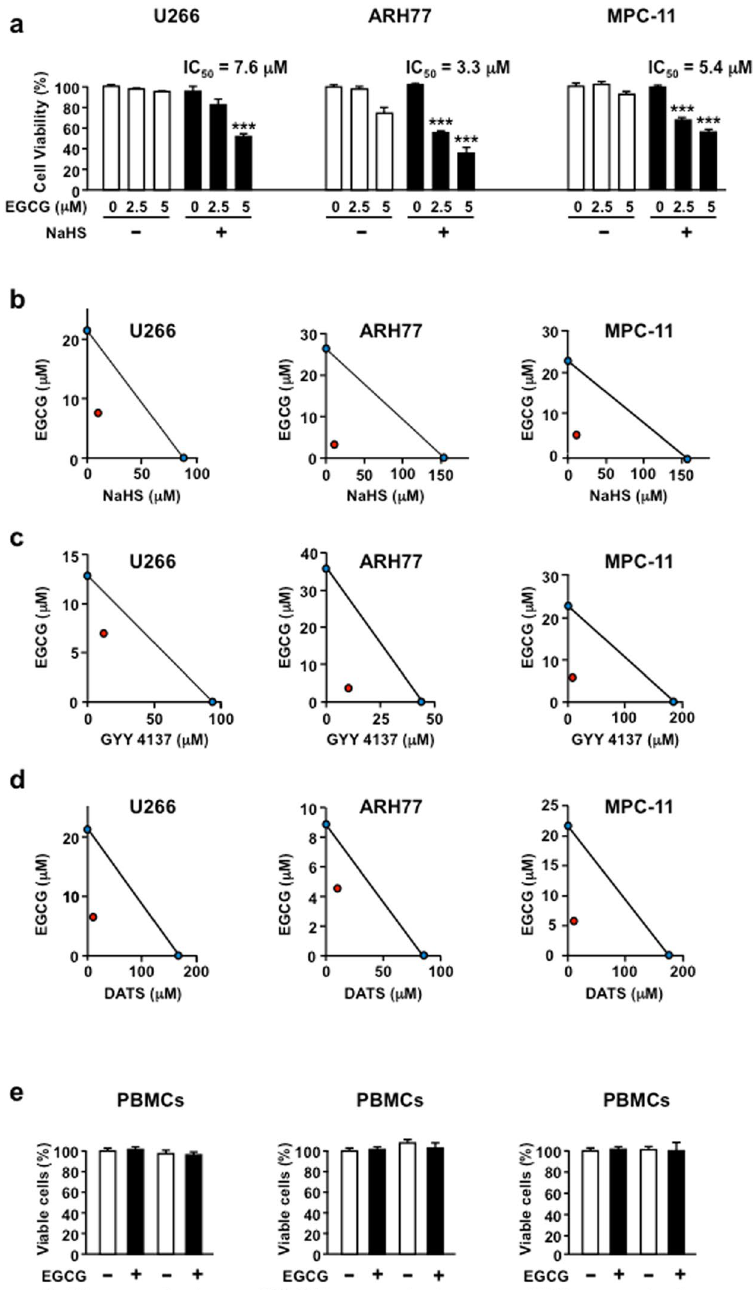
Figure 1. H 2 S donors potentiate EGCG cancer-specific cell death. ( a ) U266, ARH77 and MPC11 cells are cultured with or without NaHS (10 µ M) and/or EGCG for 96 h, and viable cell numbers are measured. ( b – d ) The combination effect of EGCG and several H 2 S donors in U266, ARH77 and MPC-11 cells are measured by isobologram analysis. ( e ) Normal PBMCs are treated with NaHS, GYY 4137 and DATS (10 µ M) with or without EGCG (5 µ M) for 96 h. Data are presented as mean ± SEM ( n = 3). ** P < 0.01, *** P <